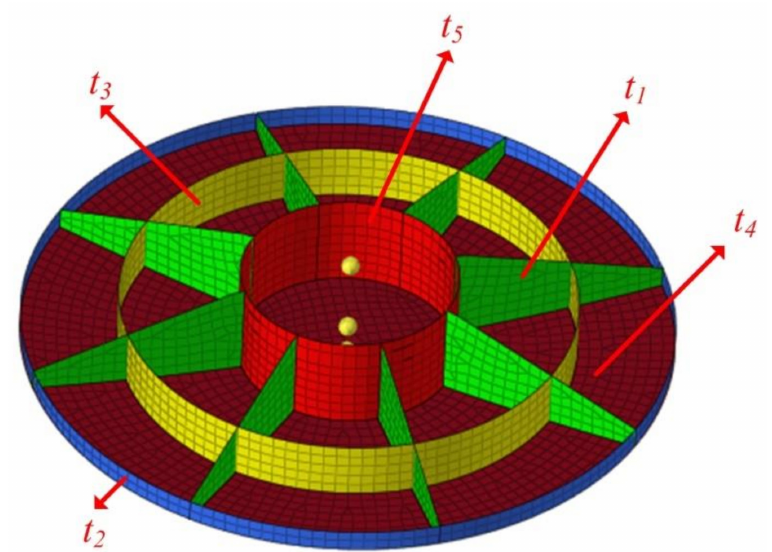
Figure 4. The grouping of lightweight